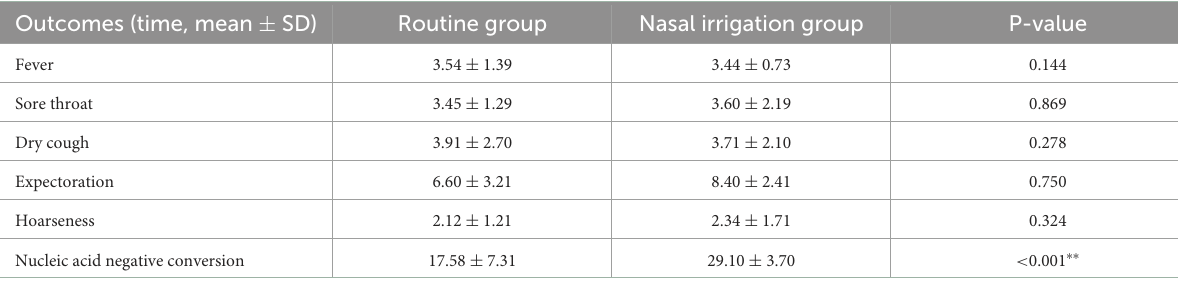
TABLE 2 Primary outcomes: symptom disappearance time and nucleic acid negative conversion time